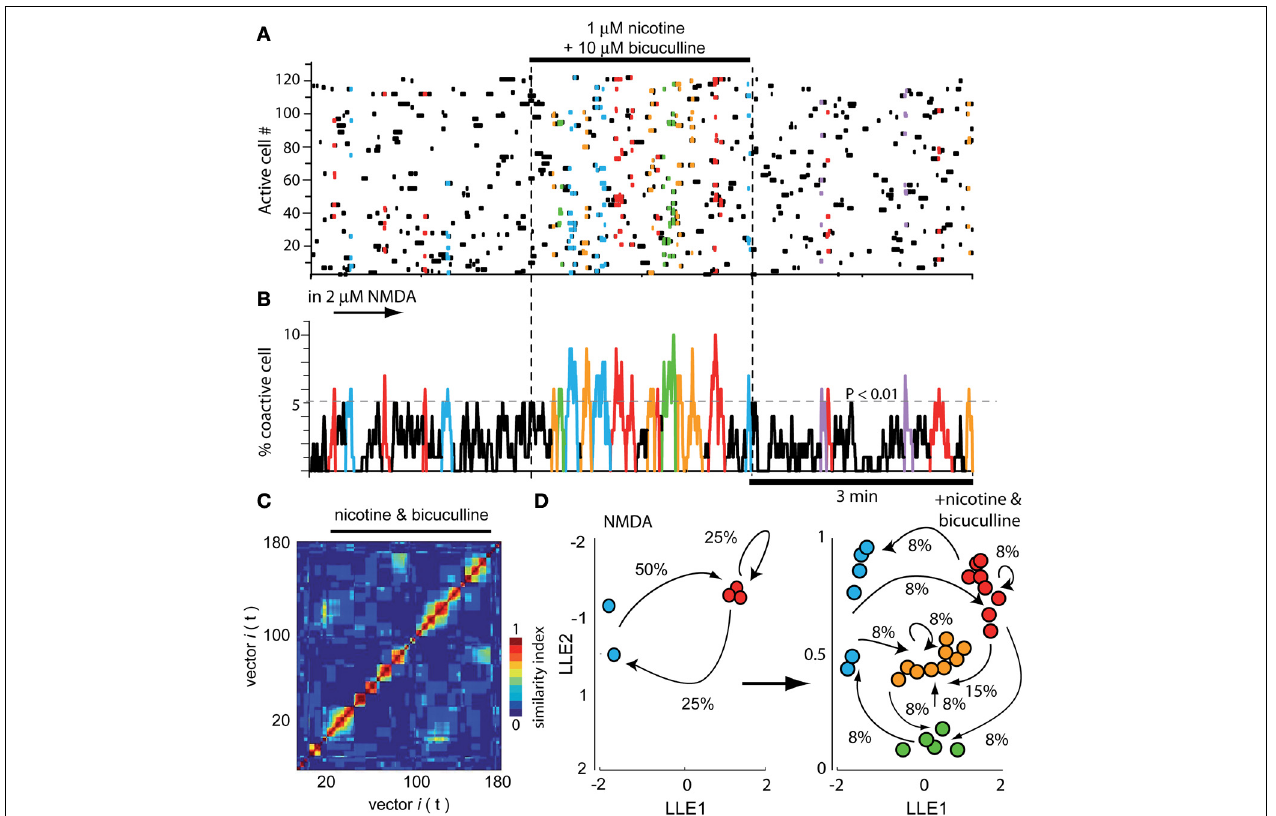
FIGURE 4 | Global actions of nicotine in the striatal circuit are blocked by bicuculline. (A) Raster plot showing again three different epochs of activity. At the left epoch, the typical activity of the striatal circuit with 2 μ M NMDA is seen displaying two neuron pools with synchronized activity (red and blue). Middle epoch: neuronal activity is dramatically increased due to the addition of 1 μ M nicotine plus 10 μ M bicuculline into the bath saline. In contrast with what happens when bicuculline is administered alone (Carrillo-Reid et al., 2008), nicotine plus bicuculline showed a quite diverse set of synchronization peaks. Right epoch: nicotine plus bicuculline actions were reversible. (B) Activity histogram of summed